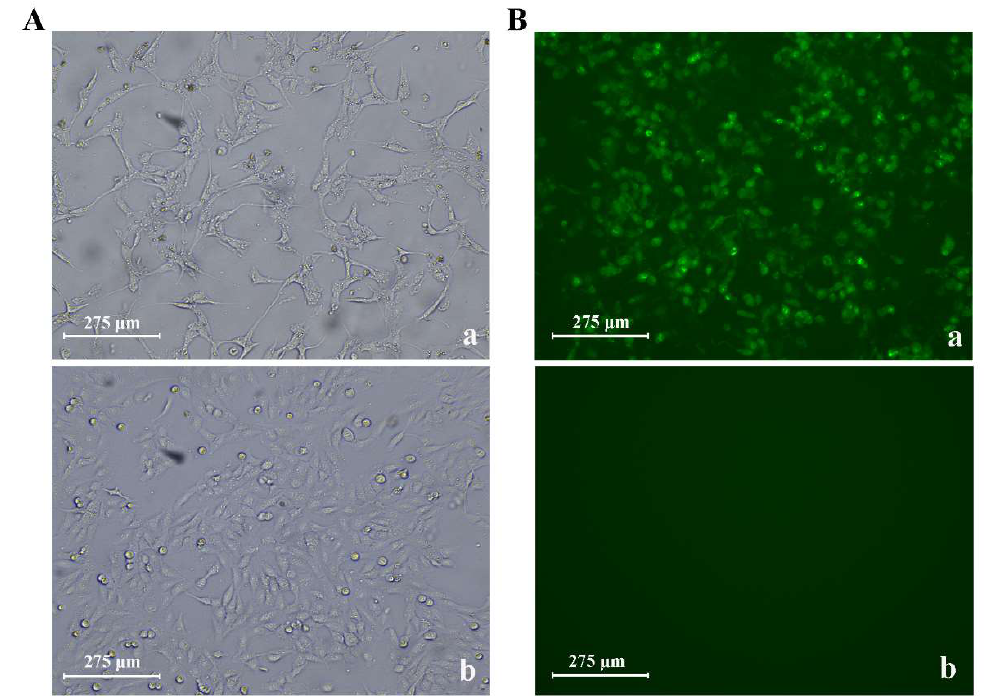
Figure 2. CPV-2 isolation and proliferation. ( A ) Typical cytopathic morphological changes in CPV-2-infected F81 cells ( a in A ) compared with the normal F81 control cells ( b in A ). ( B ) The immunofluorescence assay of the CPV-2-infected cells ( a in B ) and the normal F81 control cells ( b in B ). 182